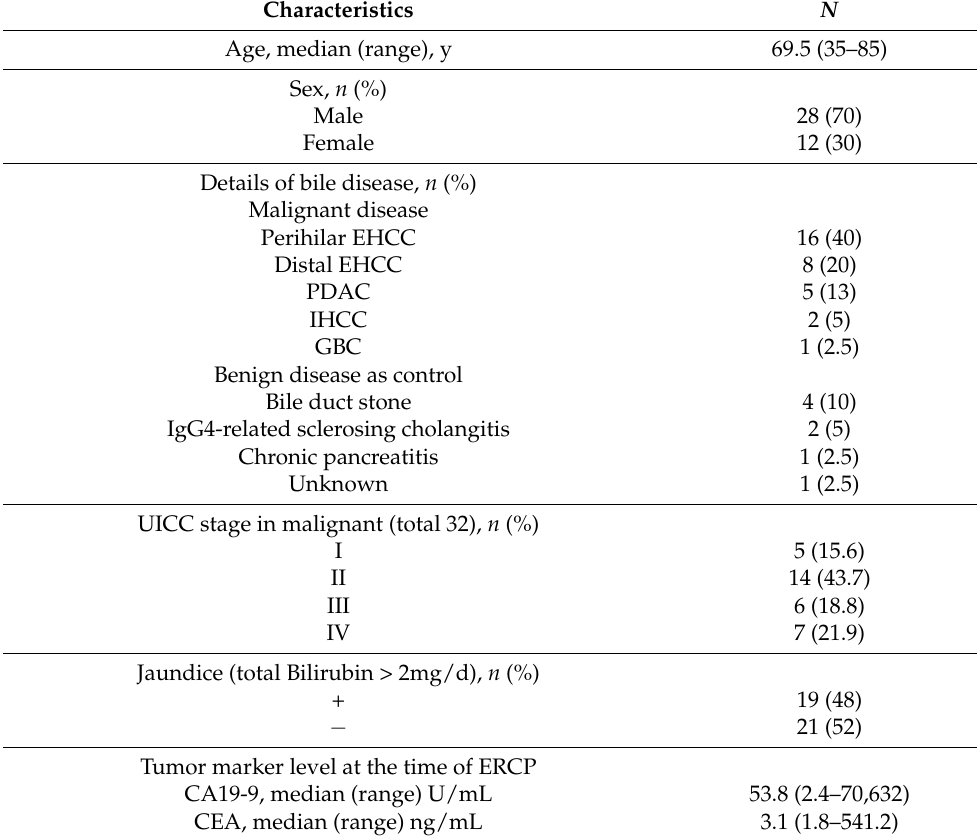
Table 2. Characteristics of 40 patients in the bile